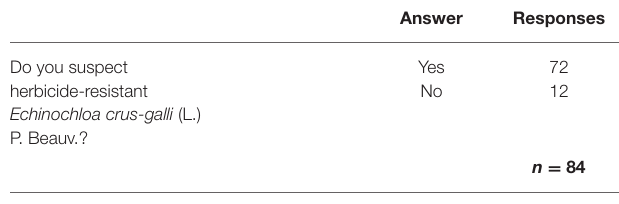
TABLE 6 | Herbicide resistance in Echinochloa crus-galli (L.) P. Beauv. across Arkansas rice hectares as reported by survey respondents a . Do you suspect herbicide-resistant Echinochloa crus-galli (L.) P.